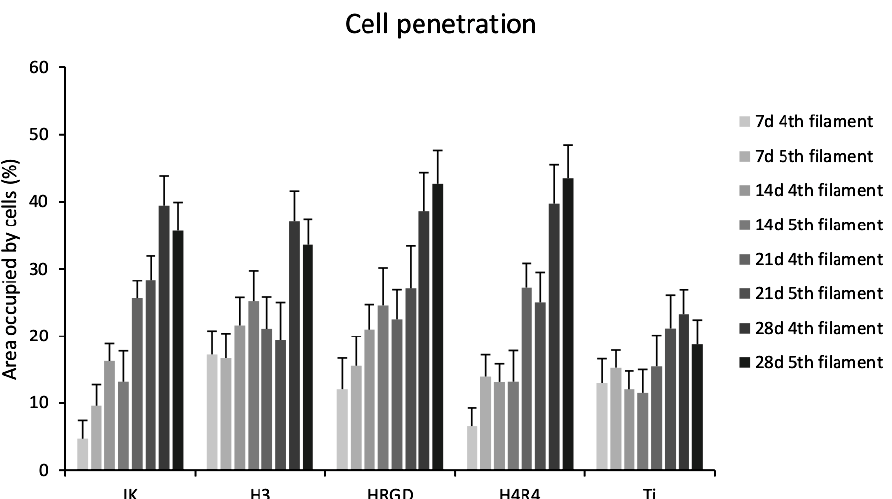
Figure 8. Quantification of the area occupied by cells on the parallel fourth and fifth filament (from the top downwards) at 7, 14, 21, and 28 days after rMSCs seeding on the different functionalized and non-functionalized Ti scaffolds.